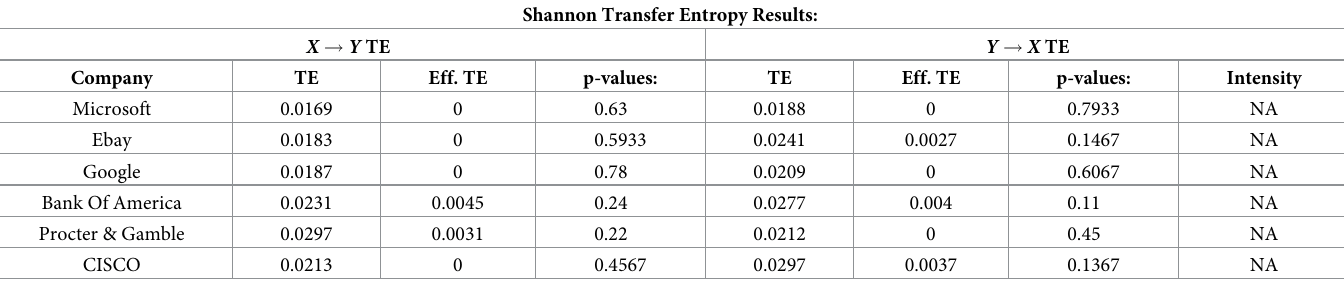
Table 4. Non existent information